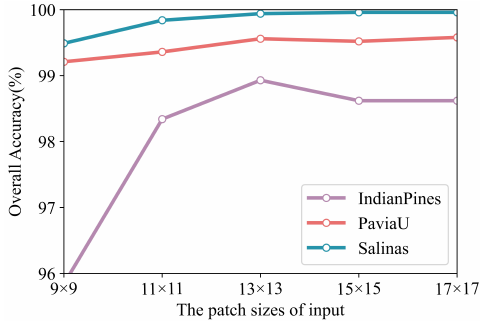
Figure 9. The OAs for three datasets with different patch